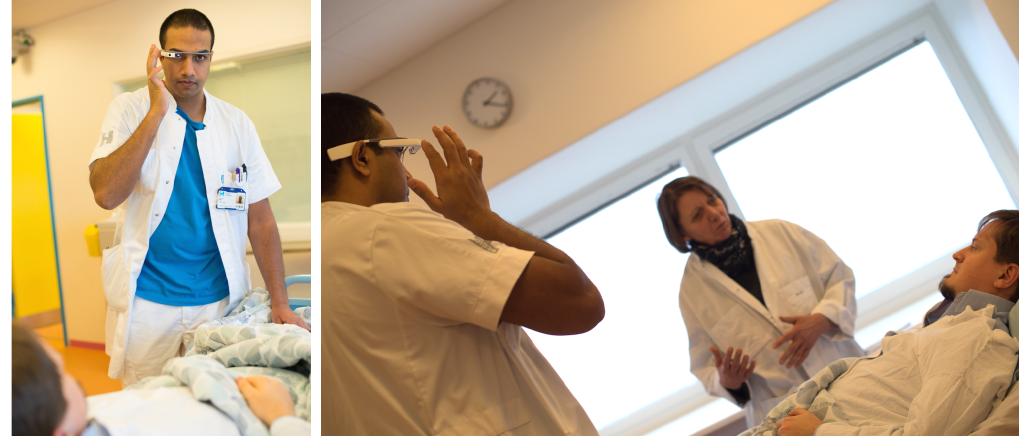
Figure 6. A surgeon uses the Wearable Personal Assistant to browse electronic patient records and X-rays in the ward round scenario.